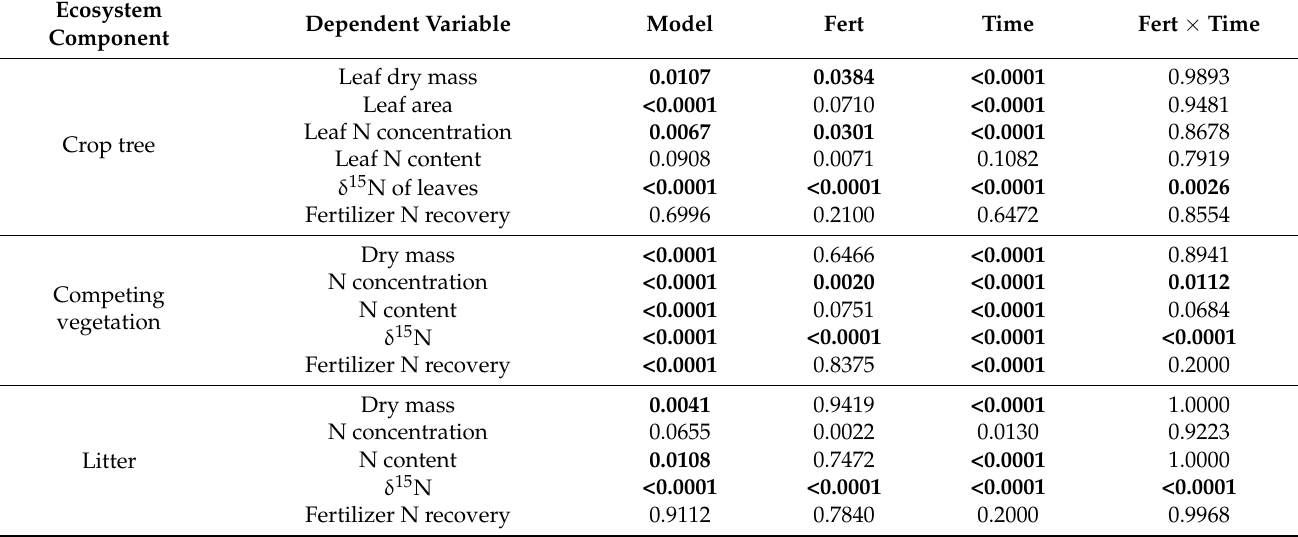
Table 1. ANOVA results for plant-related response variables. For each entry, p -values are displayed for the overall model, main effects, and all main effect interactions. Values in bold were considered significant at p < 0.05. No main effects or interactions were considered significant in the absence of overall model significance. Abbreviations: Fert = fertilizer treatment; Time = time relative to fertilization.